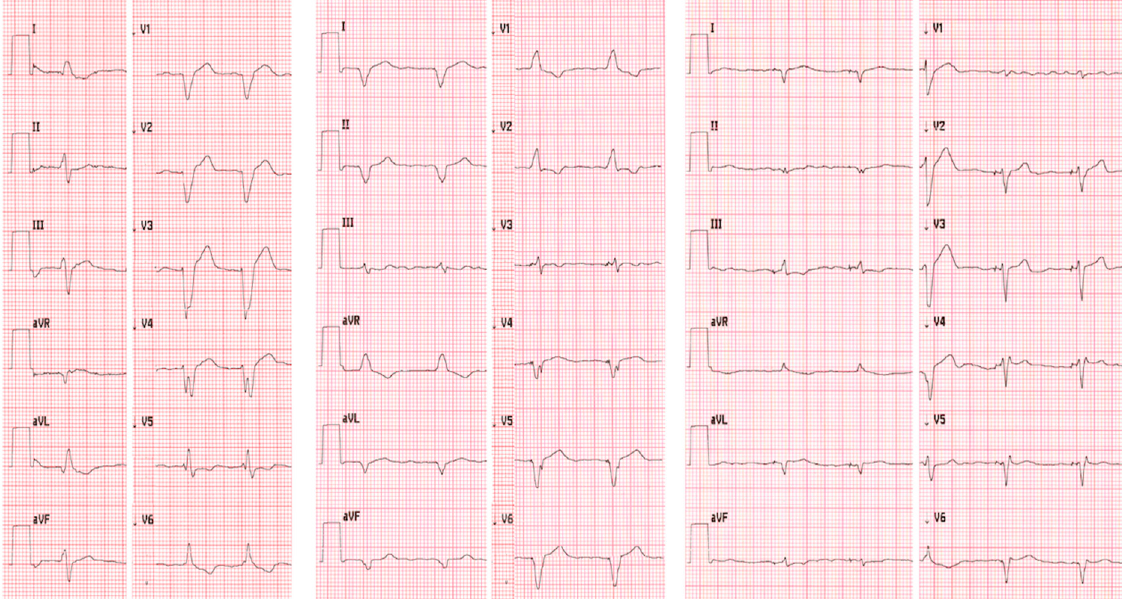
Figure 2. The 12-lead ECG of patient 2—initial QRS duration of 160 ms—left section, BiV 140 ms— middle section, HOT-CRT 120 ms—right section.